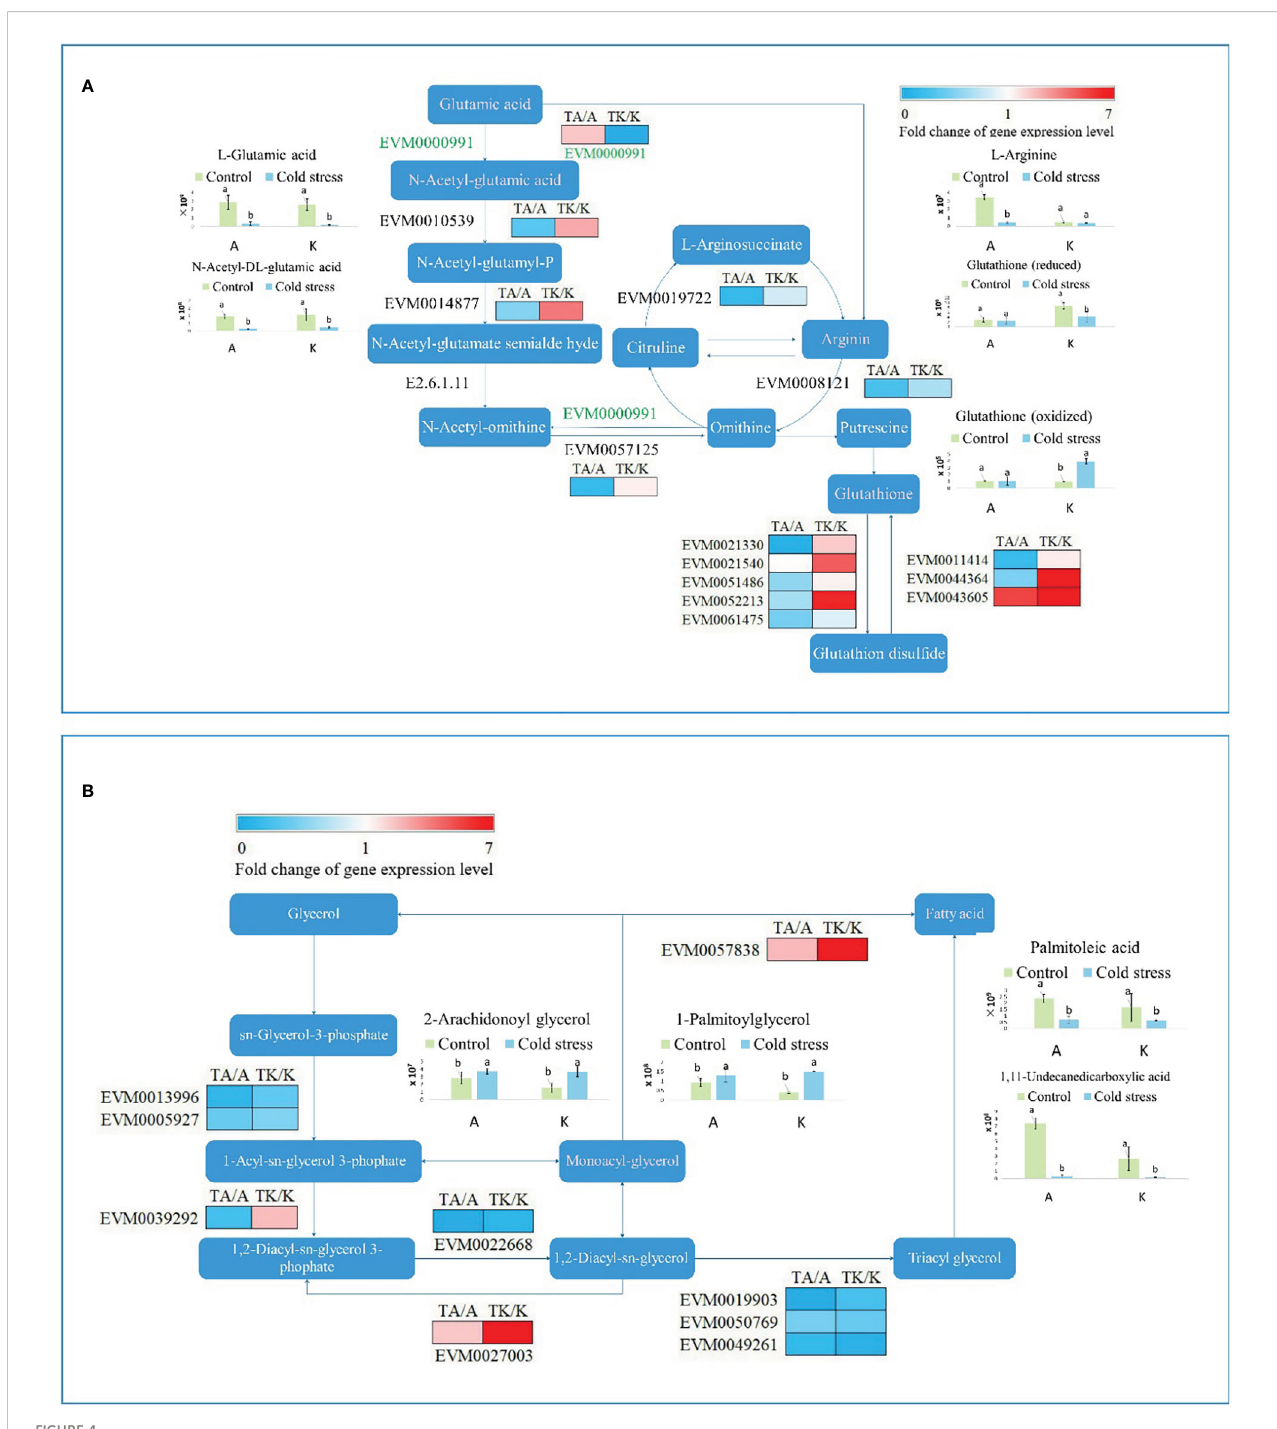
FIGURE 4 The primary metabolism pathway in fl uenced by cold stress. (A) The amino acid biosynthesis pathway. (B) The glycerolipid metabolism pathway. ‘ a ’ and ‘ b ’ represent signi fi cant difference based on least signi fi cant difference (t-test). ‘ A ’ and ‘ K ’ represent Arbequina and Koroneiki under normal conditions; ‘ TA ’ and ‘ TK ’ represent Arbequina and Koroneiki under cold